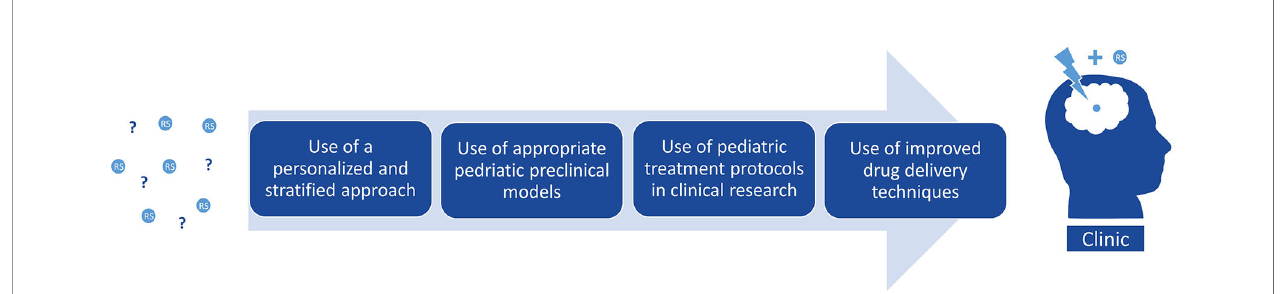
FIGURE 6 | Considerations for improved clinical translation of pre-clinical radiosensitizers in